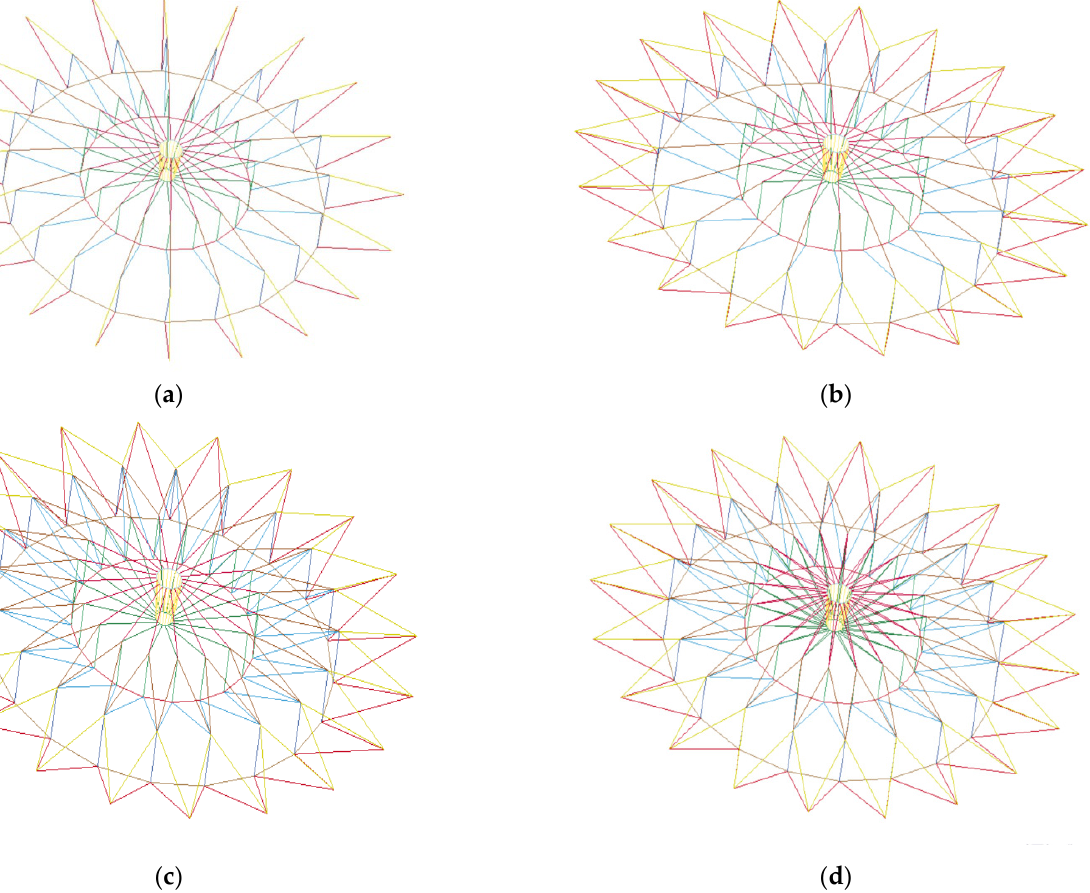
Figure 11. Topological relation diagram for the four developed cable dome models. ( a ) Dome 1,